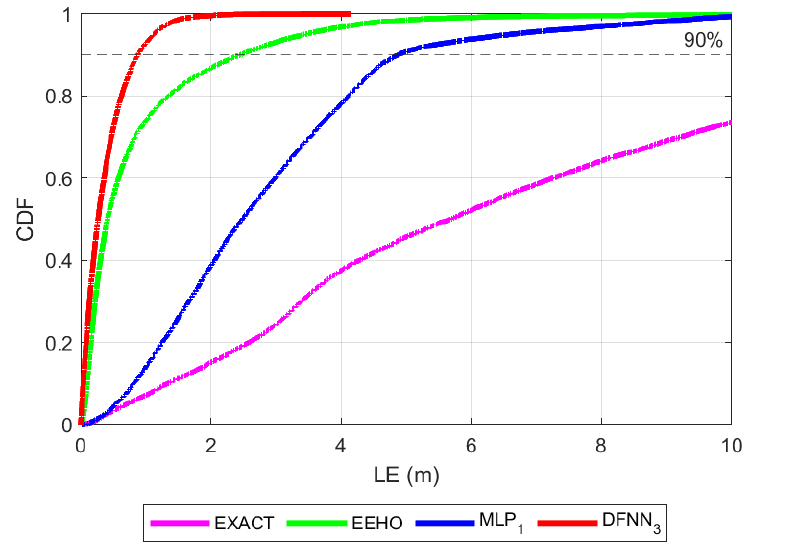
= − 80 dB and N = 3. i